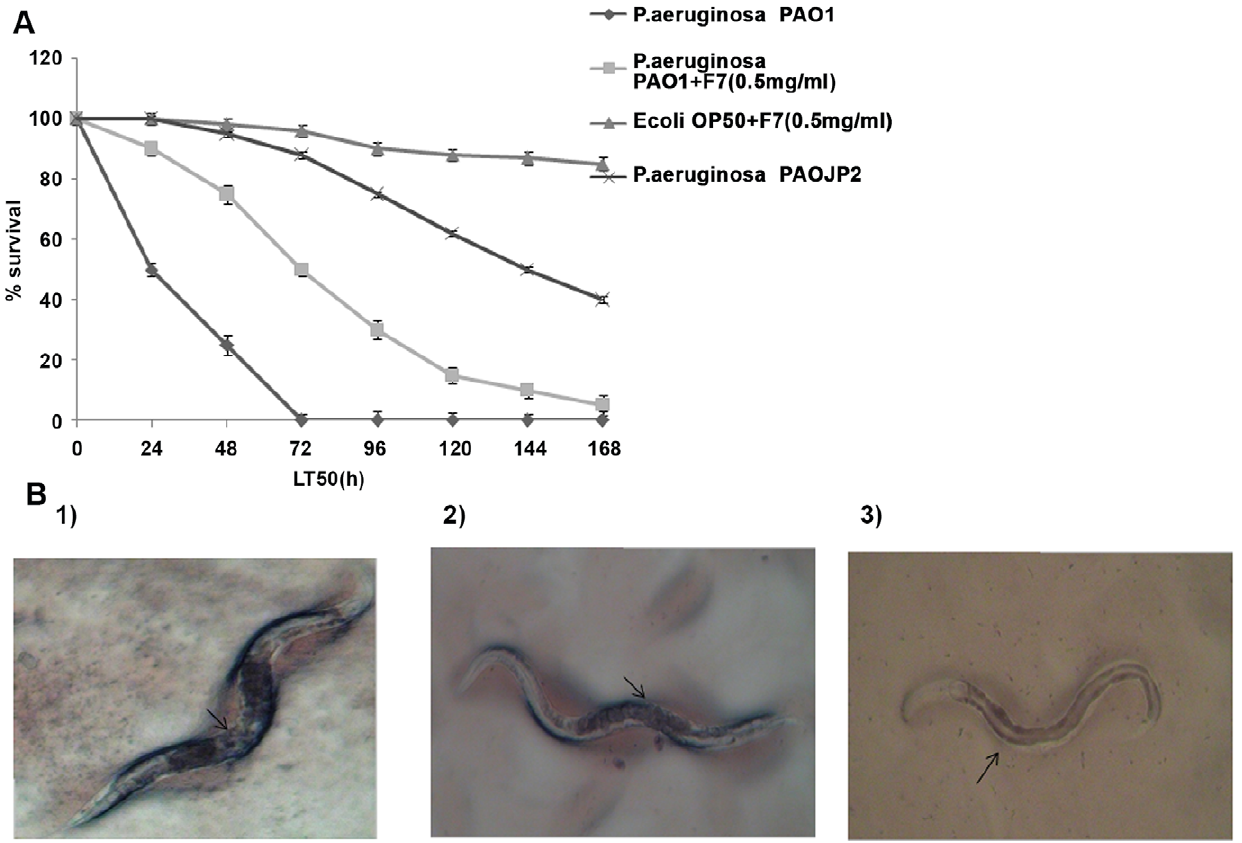
Figure 5. C.elegans - P.aeruginosa killing assay A) LT 50 of C.elegans increased from 24 to 72 h when fed on P.aeruginosa PAO1 treated with 0.5 mg/ml of F7. B) Microscopic images of C. elegans (100X) fed on 1) P. aeruginosa PAO1 2) P. aeruginosa + 0.5 mg/ml F7 3) E. coli OP50 + 0.5 mg/ml F7. doi:10.1371/journal.pone.0053441.g005 PLOS ONE | www.plosone.org